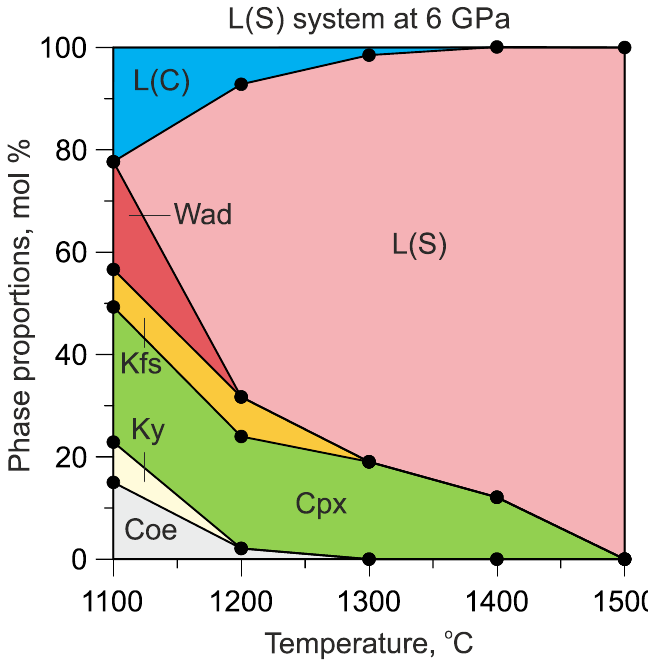
Figure 9. Calculated modes in mole fractions (Table 3) of the phases in the system L(S) as a function of temperature at 6 GPa.